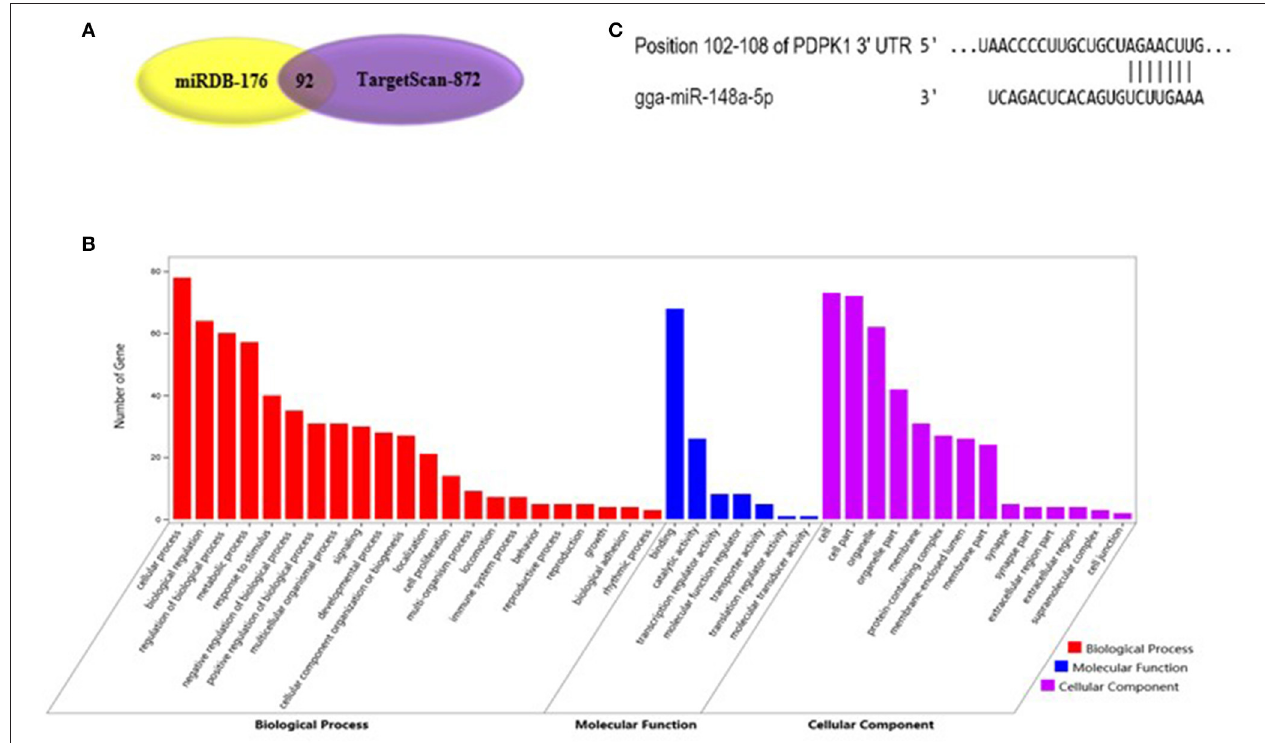
FIGURE 3 | Functional enrichment analysis of target genes. (A) The prediction of target genes using TargetScan and miRDB. (B) Histogram of GO enrichment of gga-miR-148a-5p intersection target genes. The horizontal axis represents the GO term of enrichment of differential genes, and the vertical axis represents the number of differential genes; red indicates biological process, blue indicates molecular function, and purple indicates cell component. (C) gga-miR-148a-5p and its potential target gene PDPK1 3 ′ -UTR binding site